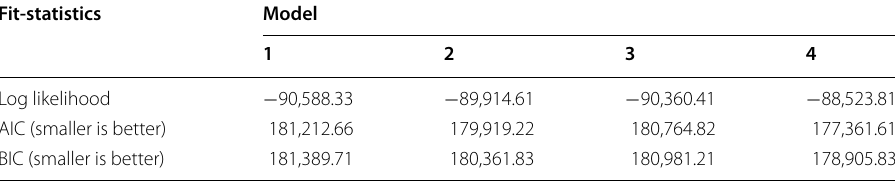
Model 1, constant discrimination parameter across countries and items; Model 2, constant discrimination parameters across items but vary across countries; Model 3 discrimination parameters are constant across countries but vary over items; Model 4, discrimination parameters vary across countries and across items